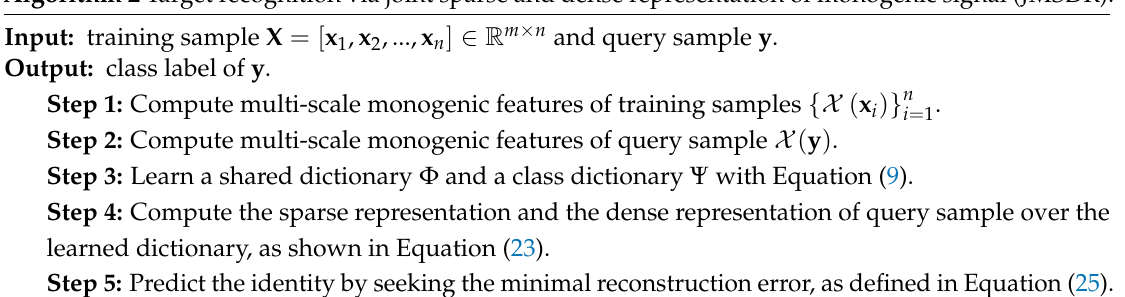
Algorithm 2 summarizes the proposed strategy JMSDR for SAR target recognition. Algorithm 2 Target recognition via joint sparse and dense representation of monogenic signal